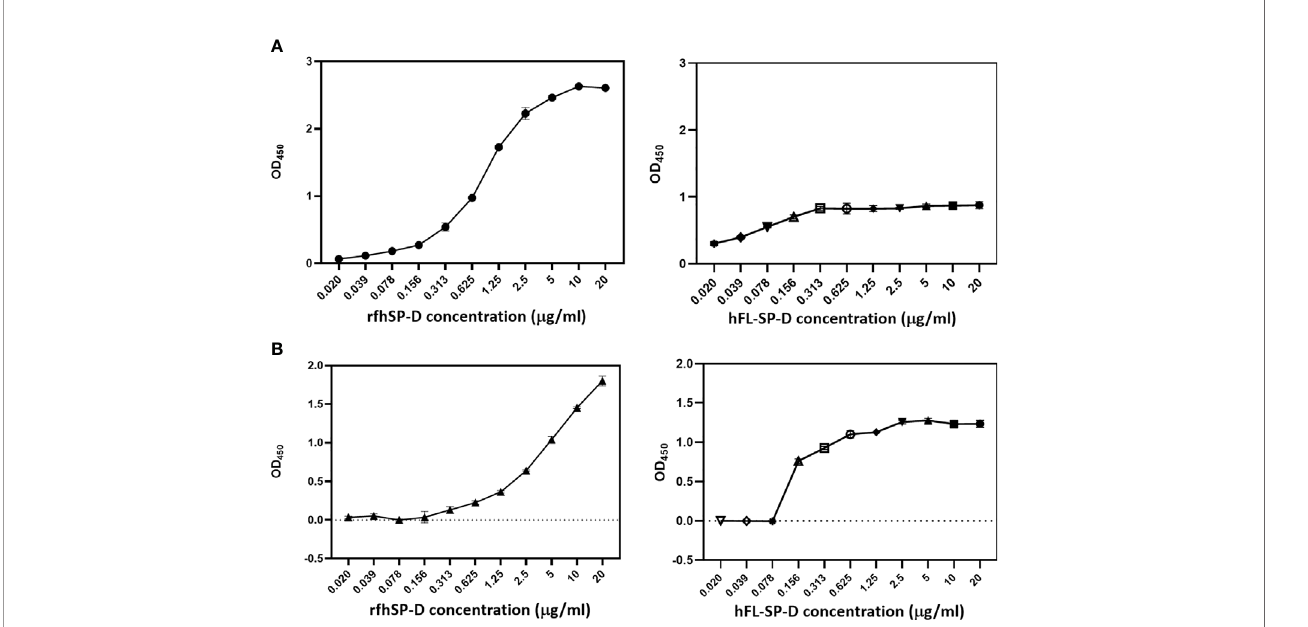
FIGURE 1 | rfhSP-D and recombinant human full-length SP-D (hFL-SP-D) binding with the spike (S1) (A) and its RBD (B) of the SARS-CoV-2 was determined via direct ELISA. Microtiter wells were coated with SARS-CoV-2 spike S1 protein (5 µg/ml) (HEK 293 cells) or RBD (5 µg/ml) (HEK 293 cells) in carbonate-bicarbonate buffer, pH 9.6 overnight at 4°C. The following day, the wells were blocked with Tris Buffered Saline (TBS) buffer containing 1% BSA and 5mM CaCl 2 , pH 7.2-7.4. After washing the wells with TBS, the wells were incubated with a series of two-fold dilutions of rfhSP-D or hFL-SP-D protein in blocking buffer at 4°C overnight. The binding between S1 protein and rfhSP-D was detected using biotinylated mouse anti-Human SP-D detection antibody (1:180), followed by probing with Streptavidin horseradish peroxidase (HRP)-conjugate 1:40. The data were expressed as mean of three independent experiments done in triplicates ± SEM. Signi fi cance was determined using the unpaired t test statistical analysis. The error bars show SEM. Control, maltose and EDTA groups compared to 2.5 µg or 5 µg S1 (RBD) in CaCl 2